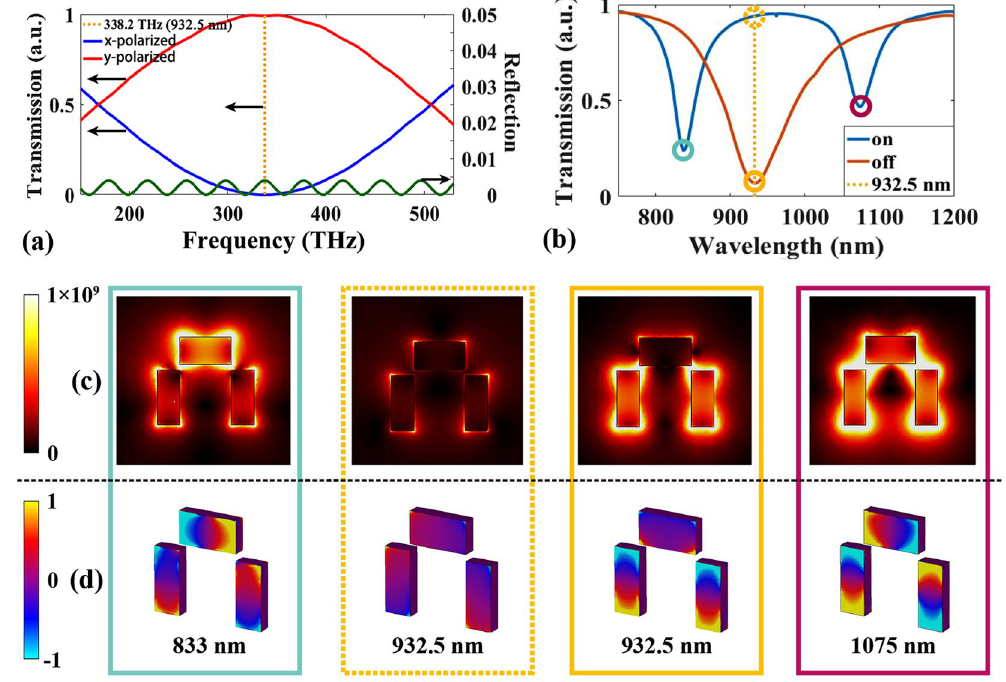
Figure 4. ( a ) Conversion for x-polarization incident light. ( b ) Spectrum comparison between the “on” and “off” states. ( c ) Electrical field distribution at the dip position of 932.5 nm in ( b ). ( d ) Corresponding charge distributions on the metasurface unit